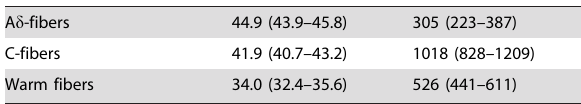
Table 2. Summary of psychophysical variables